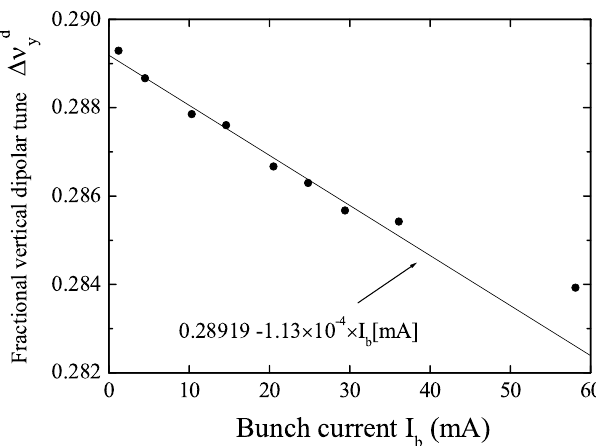
FIG. 7. Measured fractional tunes for the vertical quadrupolar oscillations as a function of the bunch current. Each closed circle indicates the most probable quadrupolar tune. The error bars indicate the uncertainty in the measurement.